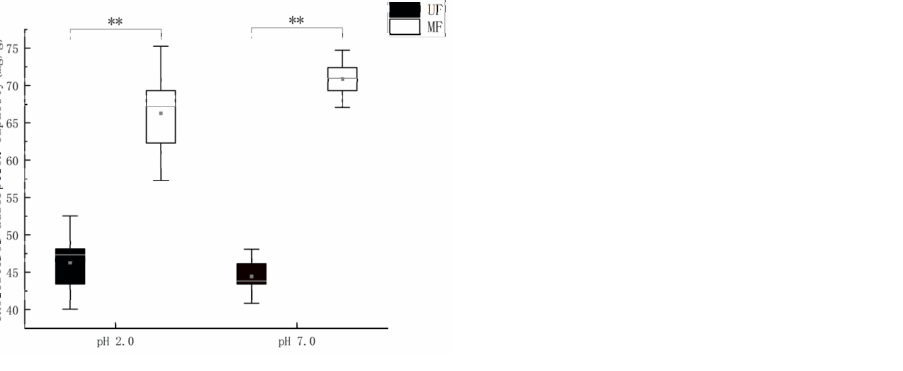
Figure 5. Cholesterol adsorption capacity of mixed fermented soybean residue. UF, unfermented soybean residue; MF, mixed fermented soybean residue. ** p < 0.01.